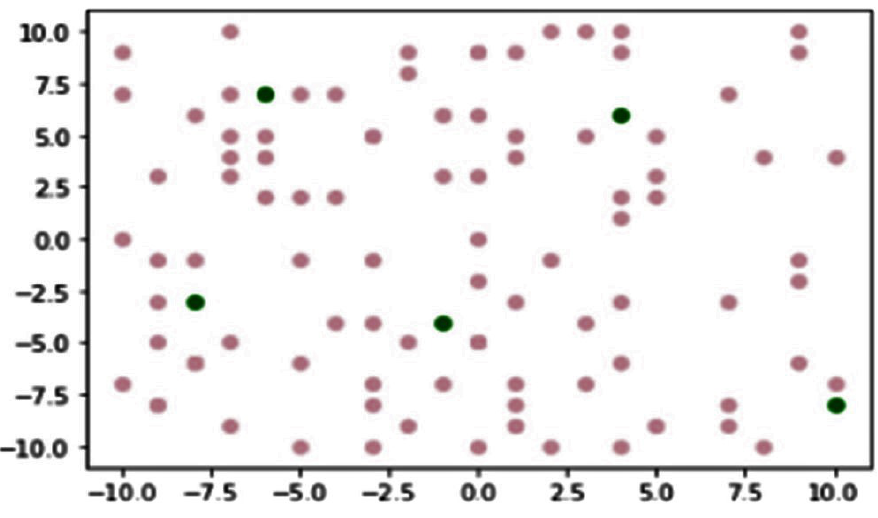
Figure 2. Cluster